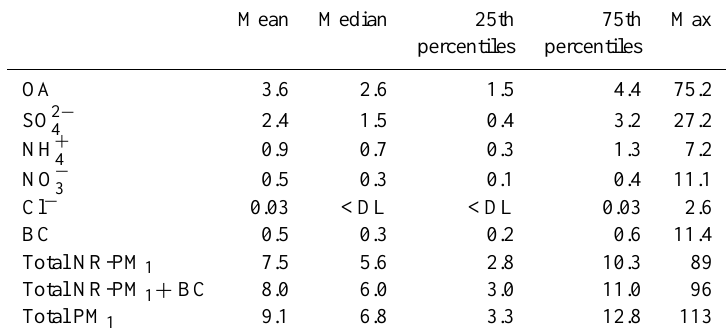
Table 1. Statistics of mass concentrations (µgm − 3 ) of the NR-PM 1 compounds, BC and total PM 1